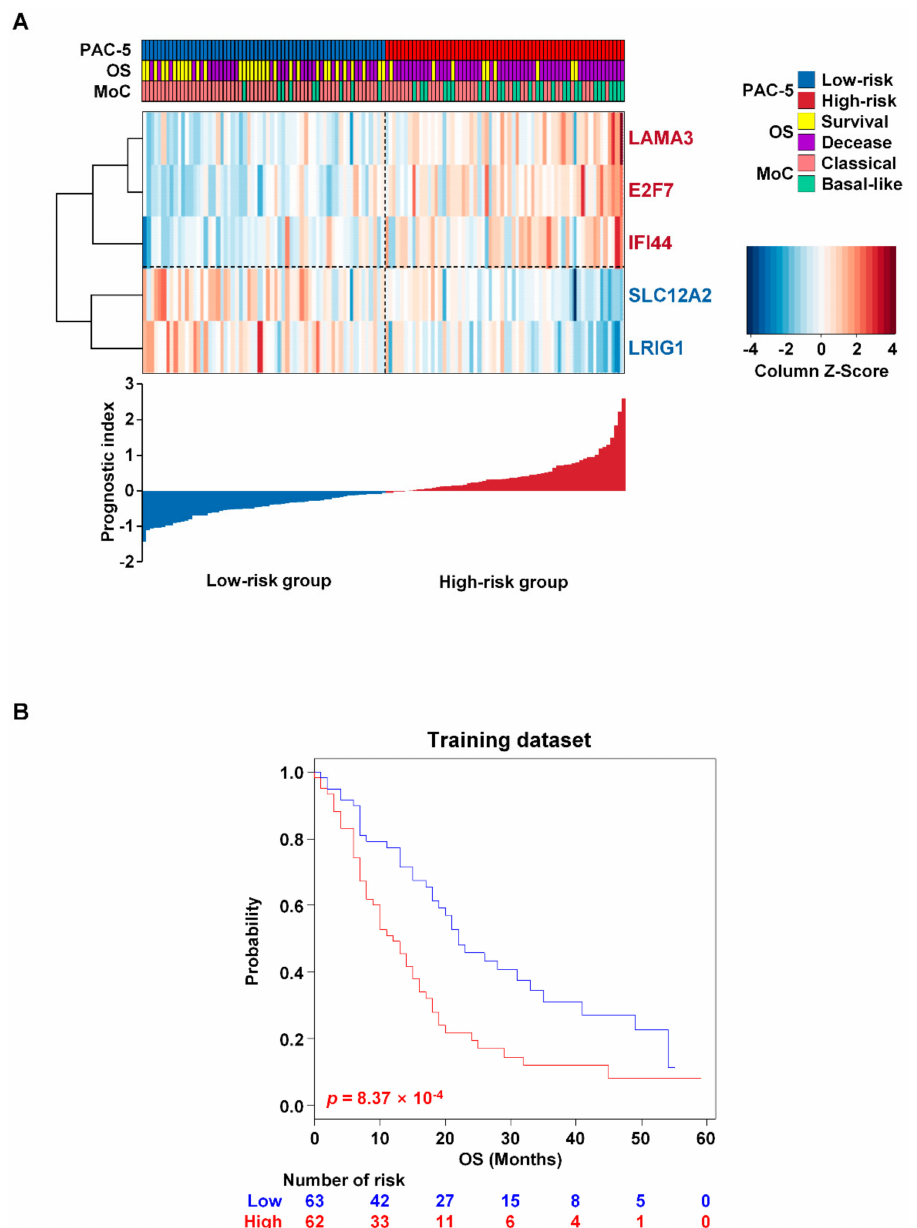
Figure 2. Establishment of the PAC-5 signature. ( A ) Survival and clinical information were associated with the heatmap of the two risk-groups in the training dataset (upper panel). The gene expression score colour keys were presented in the legends, with red indicating higher expression and blue lower expression. The patients were also clustered into two groups (classic and basal-like), based on the Mo ffi tt classification. MoC, Mo ffi tt classification. The prognostic index for each patient was calculated according to the weight of each gene (lower histogram). ( B ) Kaplan–Meier plots for OS of two risk-groups in the training dataset. p -Values were computed by log-rank